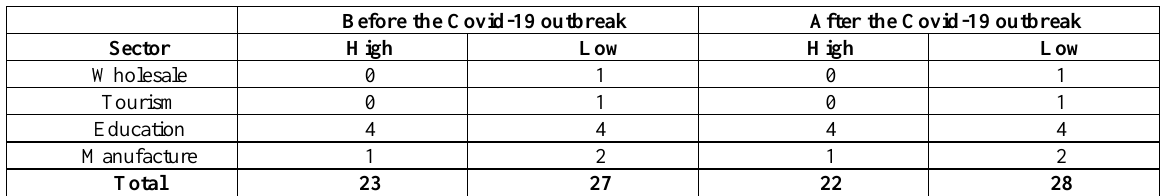
Table 4 (cont.). Sectoral distribution of the high and low digitalization scores before and after the Covid-19